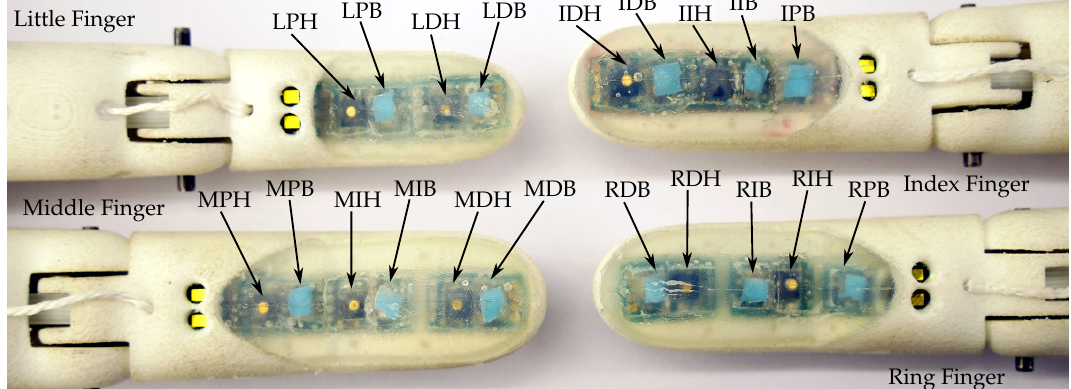
Figure 10. Identifiers for all sensors on all physical demonstrators. The identifiers are named after the first letter of the finger name, their position inside the finger and the sensor